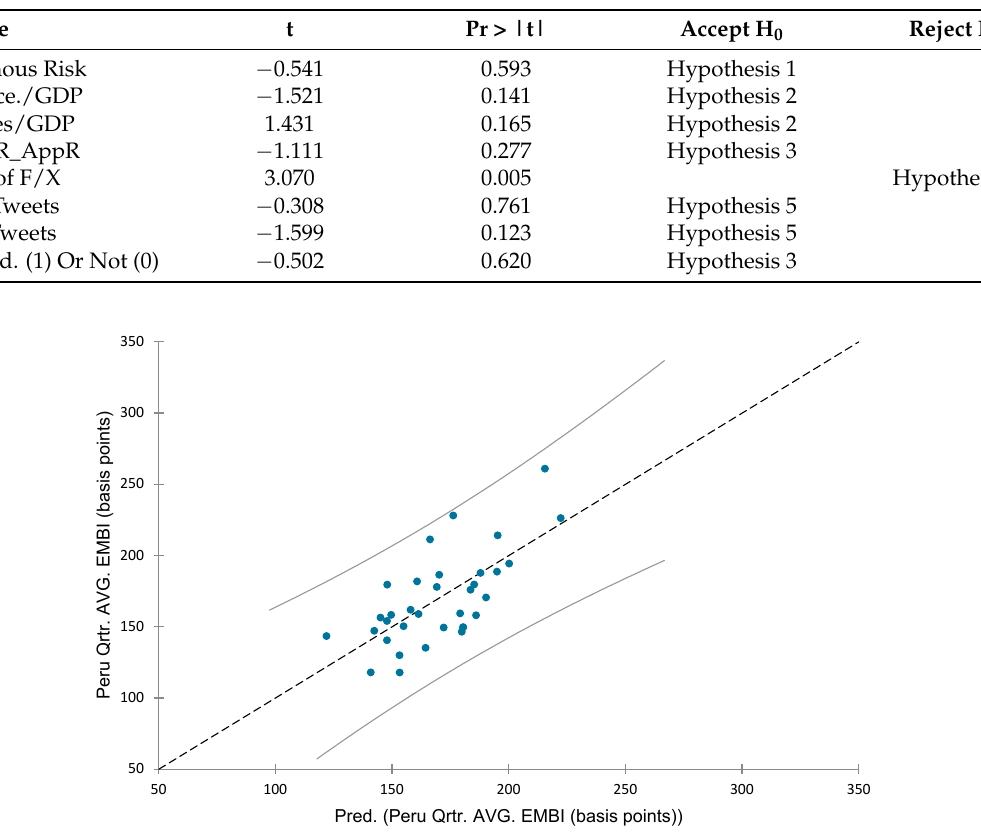
Figure 4. Peru predicted vs. actual EMBI spread.